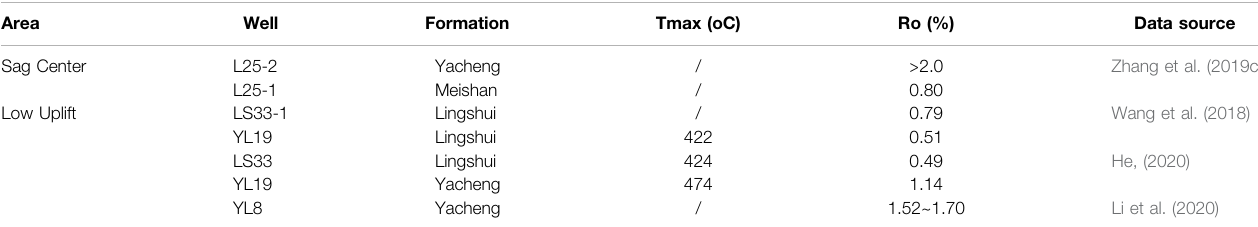
TABLE 1 | Thermal maturity of source rocks, namely, Meishan, Lingshui, and Yacheng formations, in the Sag Center and Low Uplift in the QDNB.